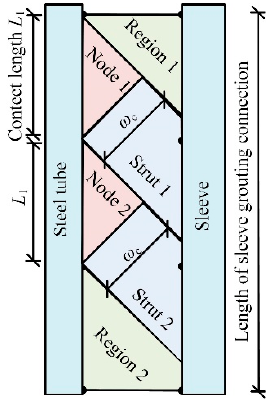
Figure 7. Sleeve grouting connection of equal height shear keys.